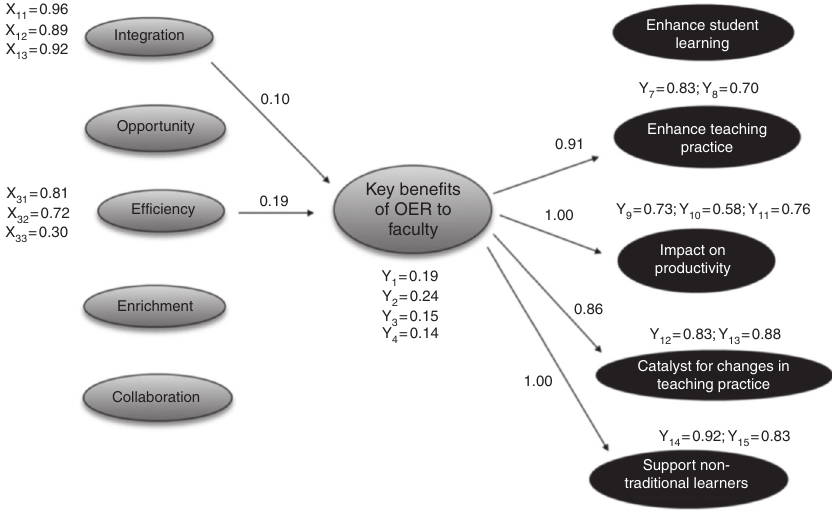
Figure 5. The loading